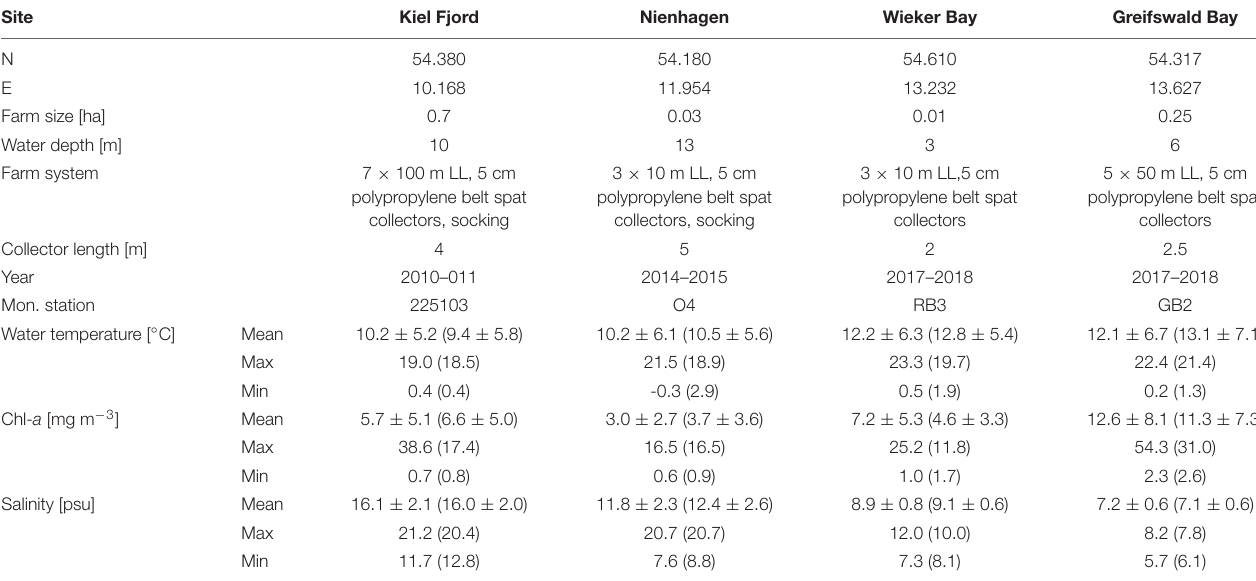
FIGURE 1 | The four study sites with mussel farms (mussel-symbol) and the 12 stations for environmental data extraction and modeled mussel growth (red circle, labeled) along the salinity gradient of the Baltic Sea. DZBC, Darss-Zingst-Bodden-Chain. TABLE 1 | Farm details and respective monitoring station (Mon. station) providing the environmental surface parameters for water temperature, chl- a and salinity from 2007 to 2017. Values for the respective study period are indicated in brackets. Site Kiel Fjord Nienhagen Wieker Bay Greifswald